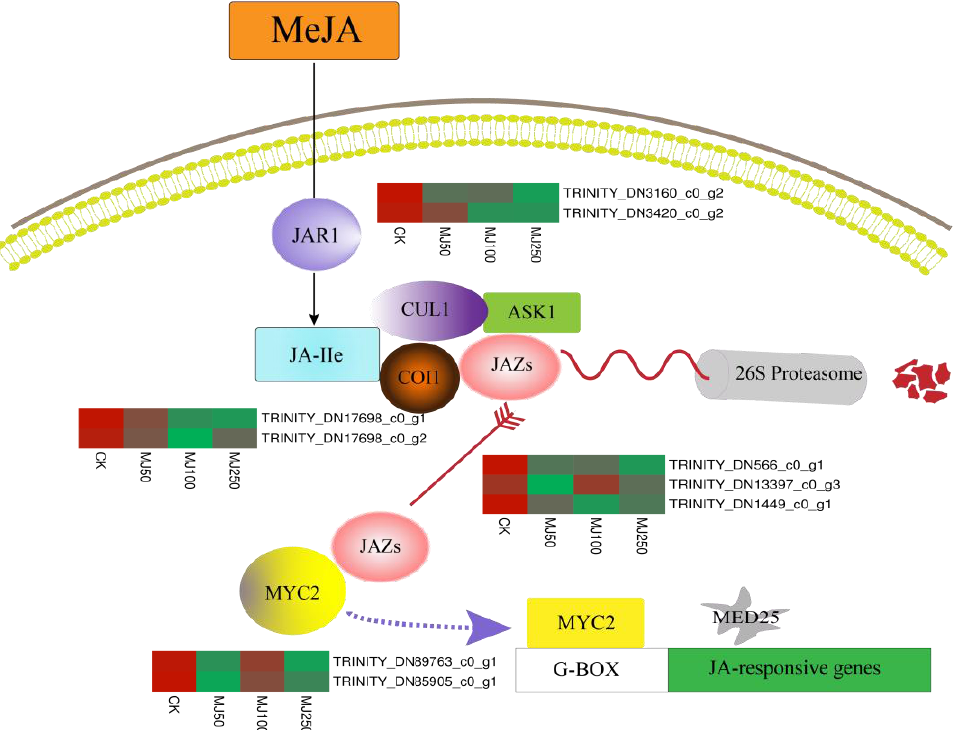
Figure 5. Expression patterns of genes involved in JA signaling. Each heat map from left to right: CK, MJ50, MJ100, MJ250. The color gradient from red to green represents transcript levels from low to high. JAR1 jasmonate − amido synthetase; COI1 coronatin − insensitive 1; JAZs Jasmonate ZIM domain (JAZ) proteins.